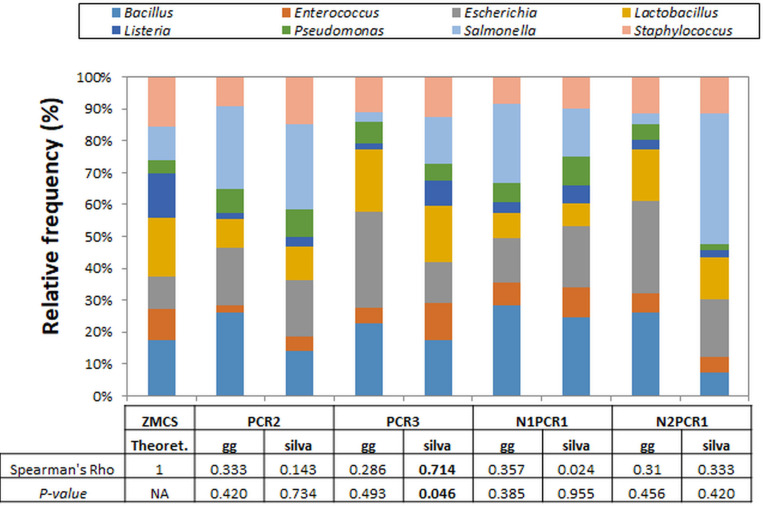
Relative abundance of ZymoBIOMICS Microbial Community Standard (ZMCS) composition according to the PCR primer pairs tested and the database used for taxonomic assignment [Greengenes_13-8 (gg) and Silva_132 (silva)]. Comparison with the theoretical abundances of ZMCS was based on Spearman correlation coefficient.